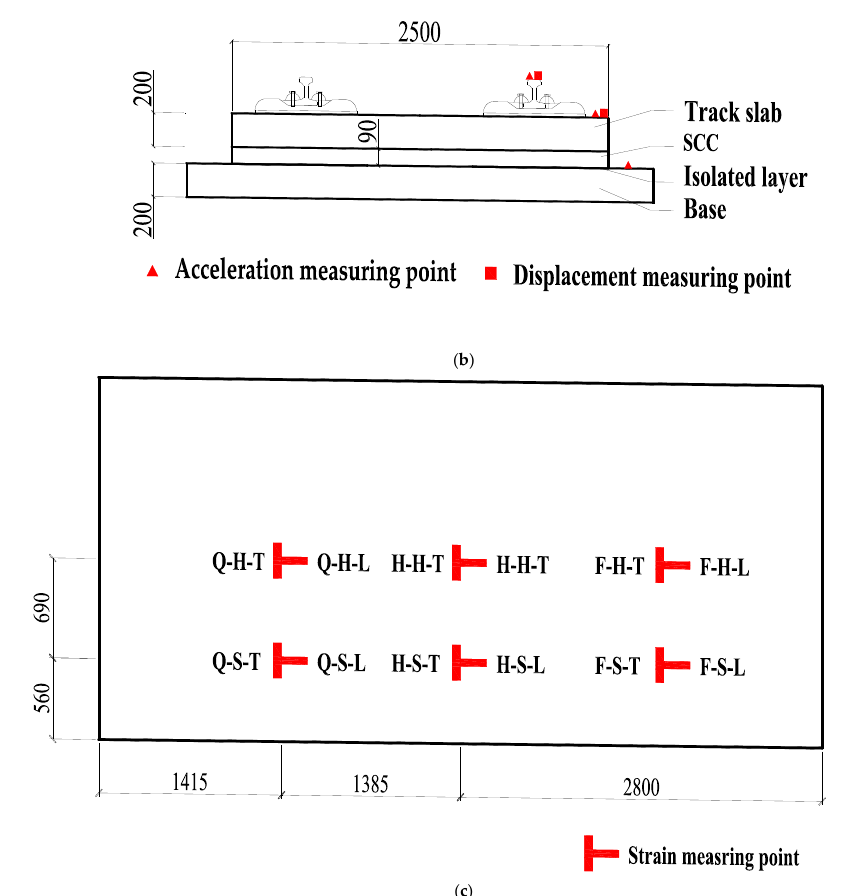
Figure 7. Test instrument layout (unit: mm): ( a ) top view of sensor layout; ( b ) side view of sensor arrangement; ( c ) top view of strain gauge layout. According to the measured data of the mechanical property evolution test of the CRTS Ⅲ SBT structure system under train load in literature [33], the test results in the static load graded loading test are compared with the finite element calculation results under the initial state (0 million times of train load) and 30 million times of train load. The com- parison indices include the displacement of the rail relative to the track slab, the displace- ment of the track slab relative to the base slab, and the stress at the corresponding position